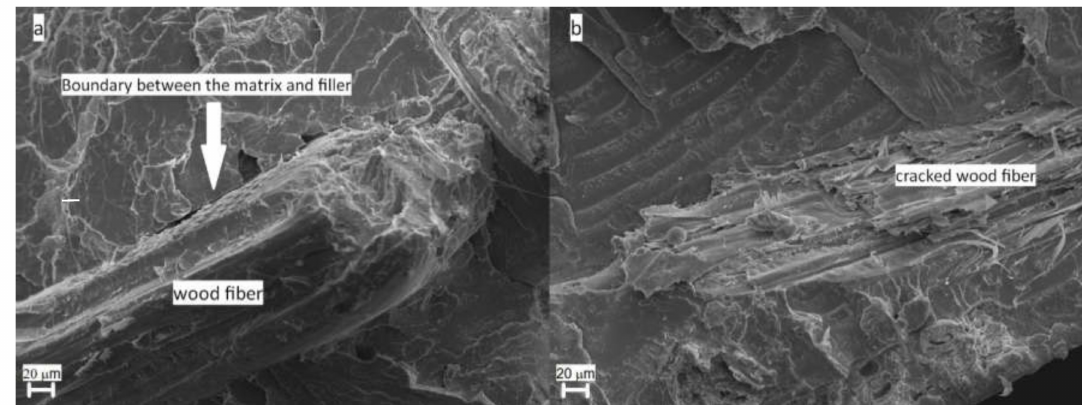
Figure 6. SEM micrographs of PLLA / 10 W ( a ) and PLLA / 10 W / APE ( b ) (800 × ).